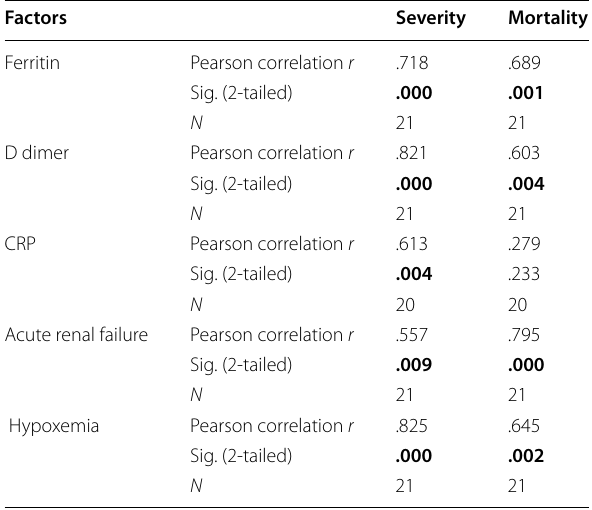
Table 5 Correlation between outcome and severity with other factors Factors